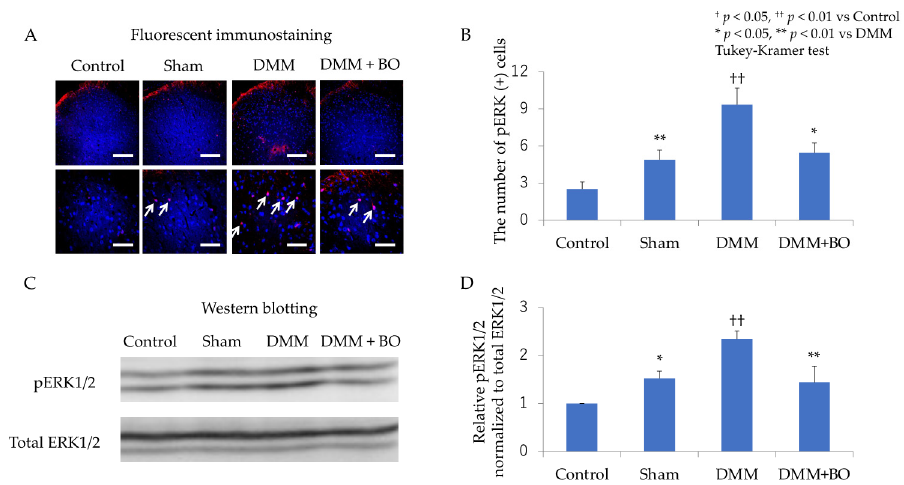
Figure 5. Expression of pERK1/2 in the right dorsal horn of the spinal cord in the chronic phase (28 days after DMM surgery). ( A ) Representative images of immunofluorescence staining in each group (red, pERK1/2; blue, nucleus). Upper images; magnification: × 200, Scale bar = 150 µ m. Lower images; magnification: × 600, Scale bar = 50 µ m. White arrow ( (cid:37) (cid:3) ) indicates a pERK1/2-positive cell. ( B ) The numbers of pERK1/2-positive cells. Each n = 5, †† p < 0.01 vs. control, * p < 0.05, ** p < 0.01 vs. DMM. ( C ) Immunoblot images of pERK1/2 and total ERK1/2 in the right dorsal horn of the spinal cord. ( D ) The quantified data of the immunoblot for pERK1/2 normalized to total ERK1/2. Each n = 5, †† p < 0.01 vs. Control, * p < 0.05, ** p < 0.01 vs. DMM. All data are presented as mean ± standard deviation. pERK, phosphorylated extracellular signal-regulated kinase; DMM, destabilization of the medial meniscus; BO,